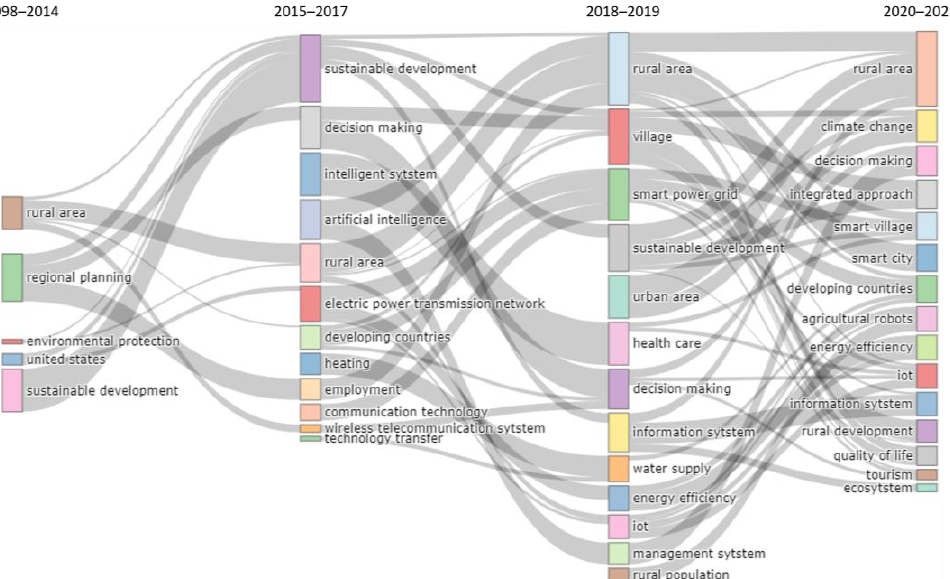
Figure 9. Sankey diagram based on the thematic evolution of keywords (1998–2021). The colors of theme clusters in the Sankey diagram are consistent with those in the strategic diagrams.